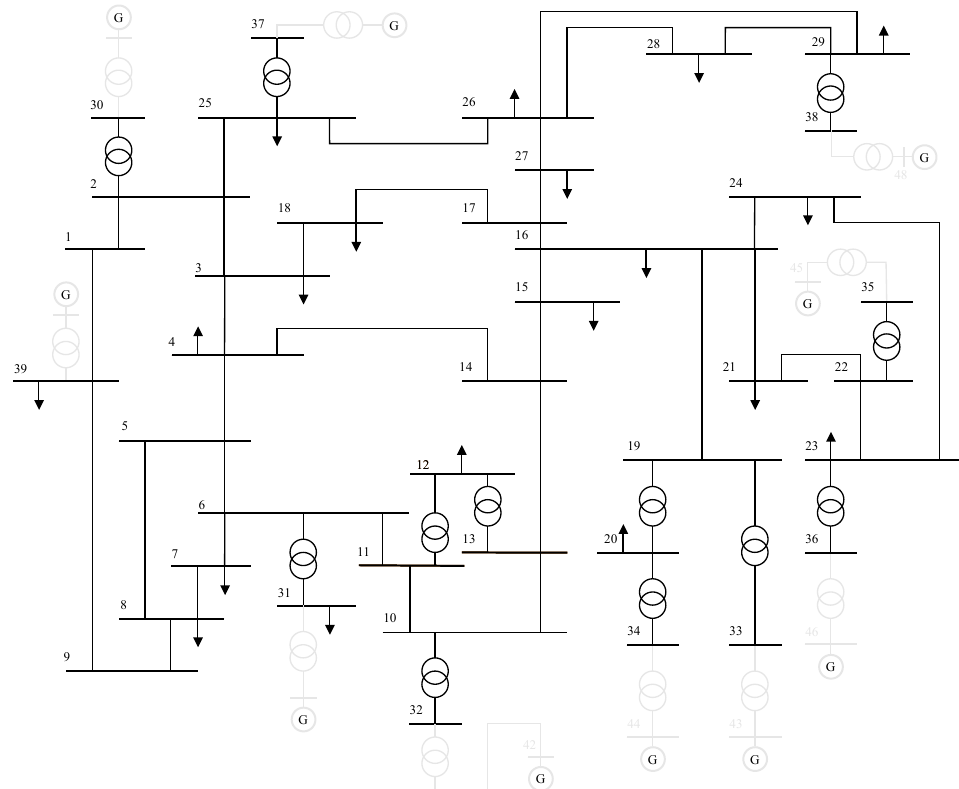
Figure 10. Single-line diagram of the IEEE-39 bus